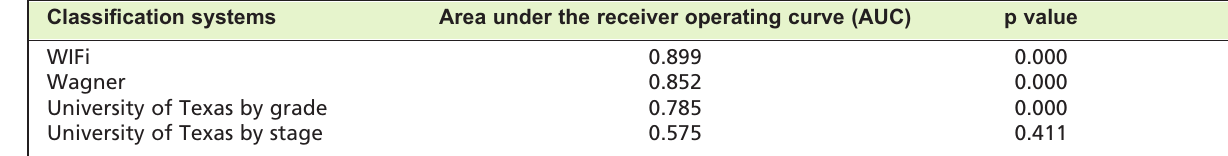
Predictive Capability of WIFi, Wagner and the University of Texas classifications for major amputation among Table III: patients with diabetic foot Classification systems